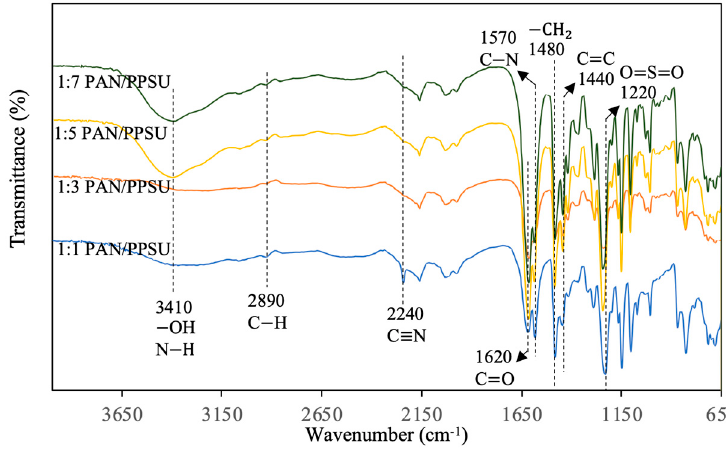
Figure 4. FTIR spectra of TFC NF membranes made of different substrates.